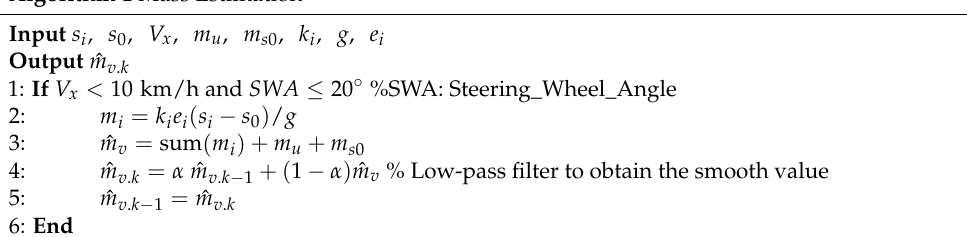
Algorithm 1 Mass Algorithm 1 Mass Estimation